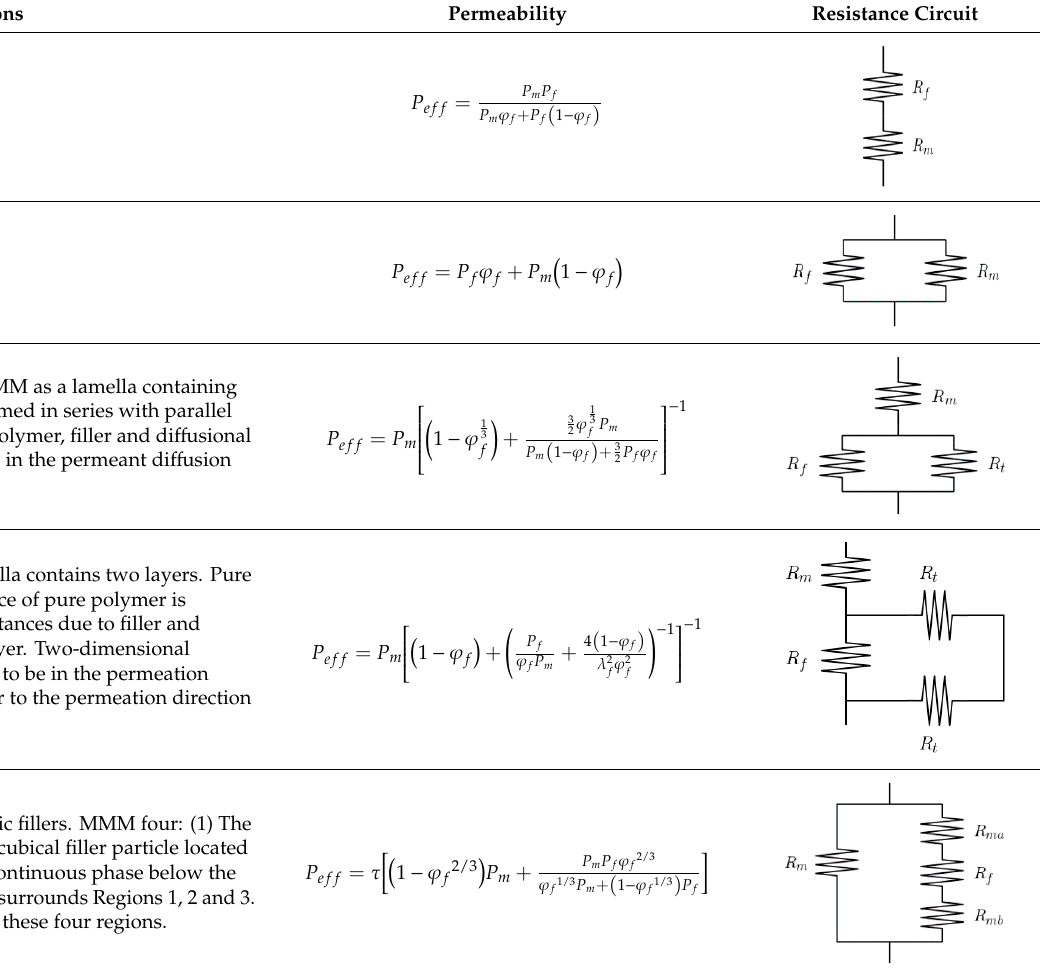
Table 2. Effective medium theory-based models.